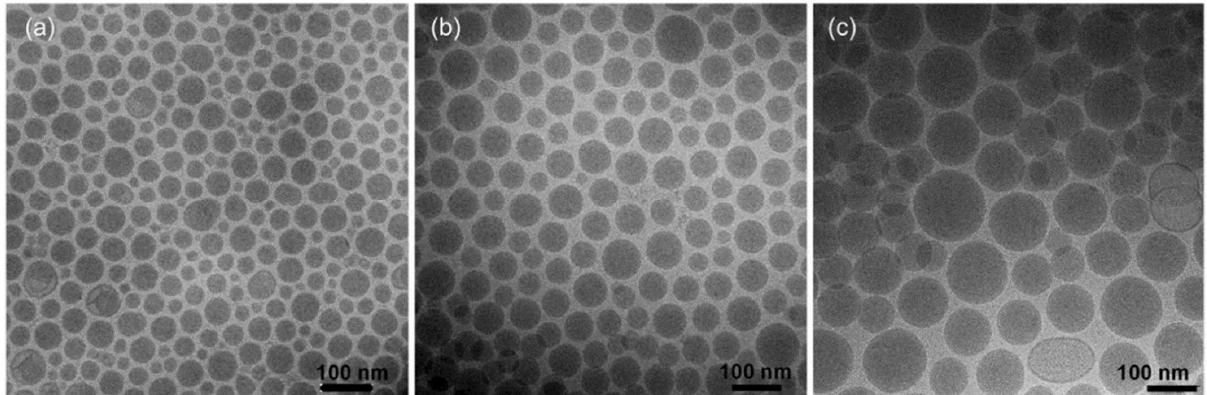
Figure 4. Cryo-TEM images of LNPs composed of DLin-MC3-DMA/DSPC/Chol/DMPE-PEG2000 in the ratio of 50:10:40-X:X for X:3 ( a ), 1.5 ( b ), and 0.5 ( c ). Reprinted with permission from [76] .